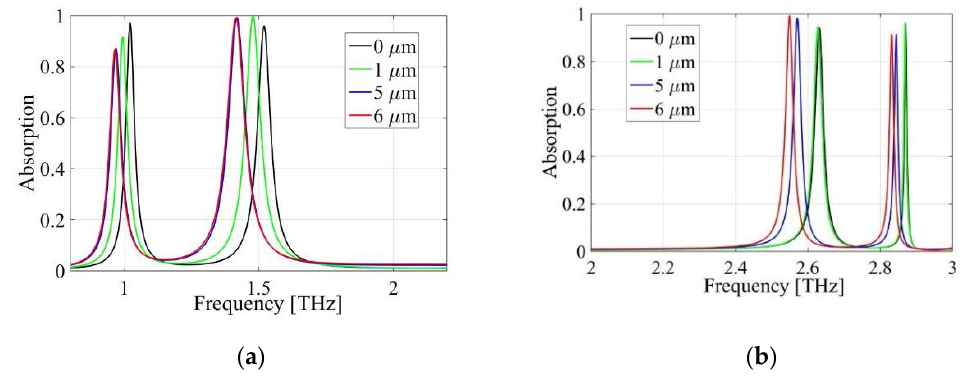
Figure 5. Comparison between absorption responses of sensor with different thicknesses of H9N2 sample for ( a ) SquarePMA and ( b ) CrossPMA.